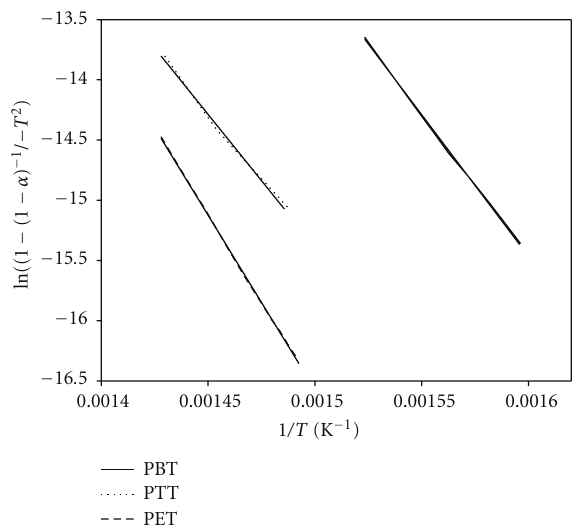
Figure 3: Plot of ln[1 − (1 − α ) − 1 ] / − T 2 versus 1 /T for di ff erent polyesters degraded in air atmosphere (zone 1).